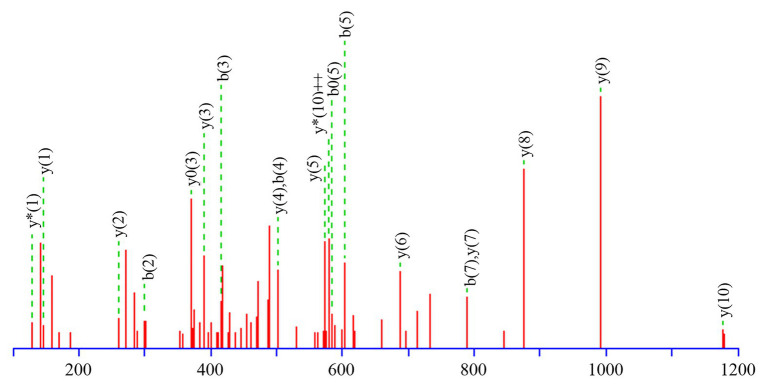
b and y ions annotation of MS/MS fragmentation of IWDSTDALELK.